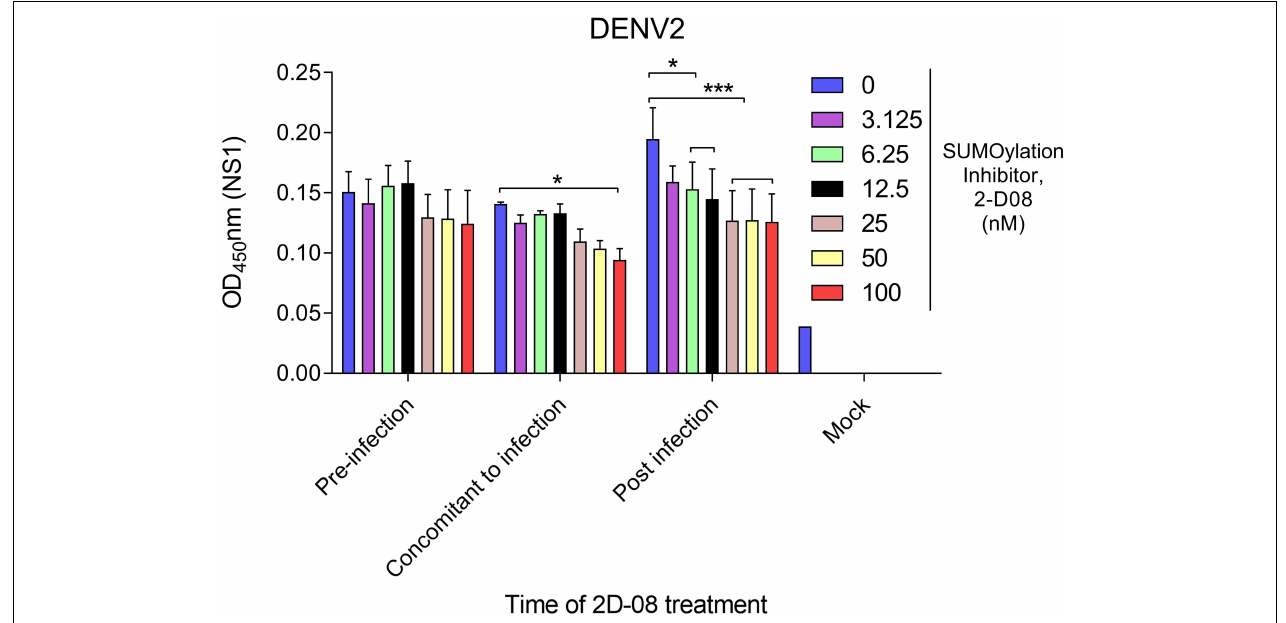
FIGURE 2 | Ubc9 inhibition blocks viral replication post-entry. Time-of-drug administration experiments with Ubc9 inhibitor 2-D08. A. aegypti CCL-125 cells infected with DENV2 at MOI 1 were treated with inhibitor as indicated. Intracellular DENV NS1 protein was measured by cell-based ELISA. Comparisons were performed using the Tukey’s multiple comparison test with DMSO control group (0 nM); * p ≤ 0.05, *** p <